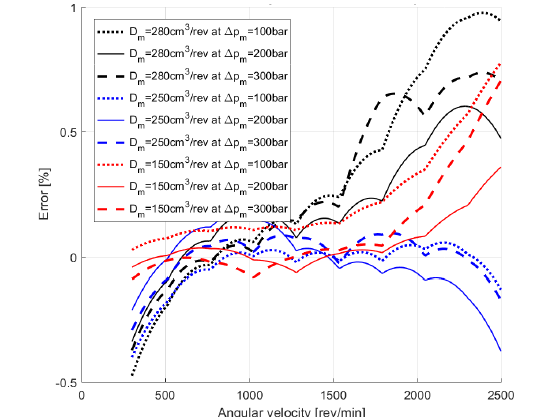
Figure 8: Error between model, MJ4, and the perfor- mance data from supplier. Error is mea-